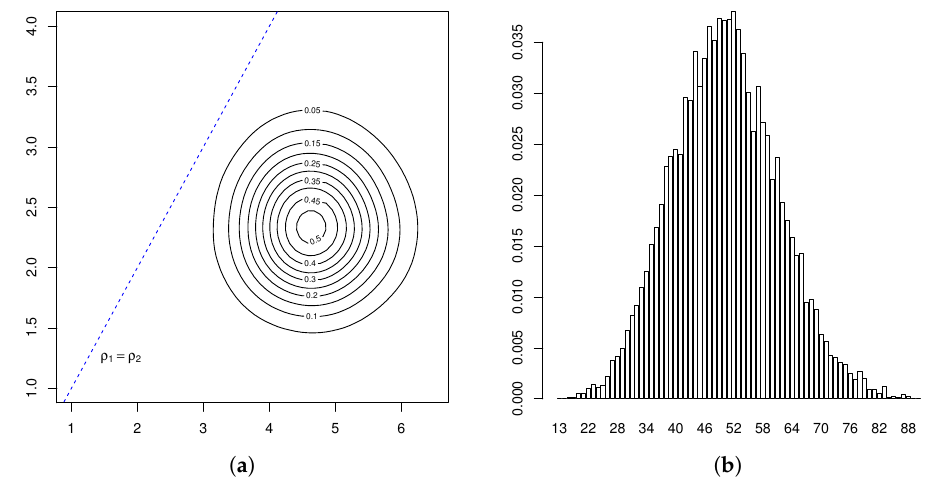
Figure 4. Contour plot of ( ρ 1 , ρ 2 ) |FM 4 ( a ) and estimated predictive distribution F 5 |FM 4 ( b ).